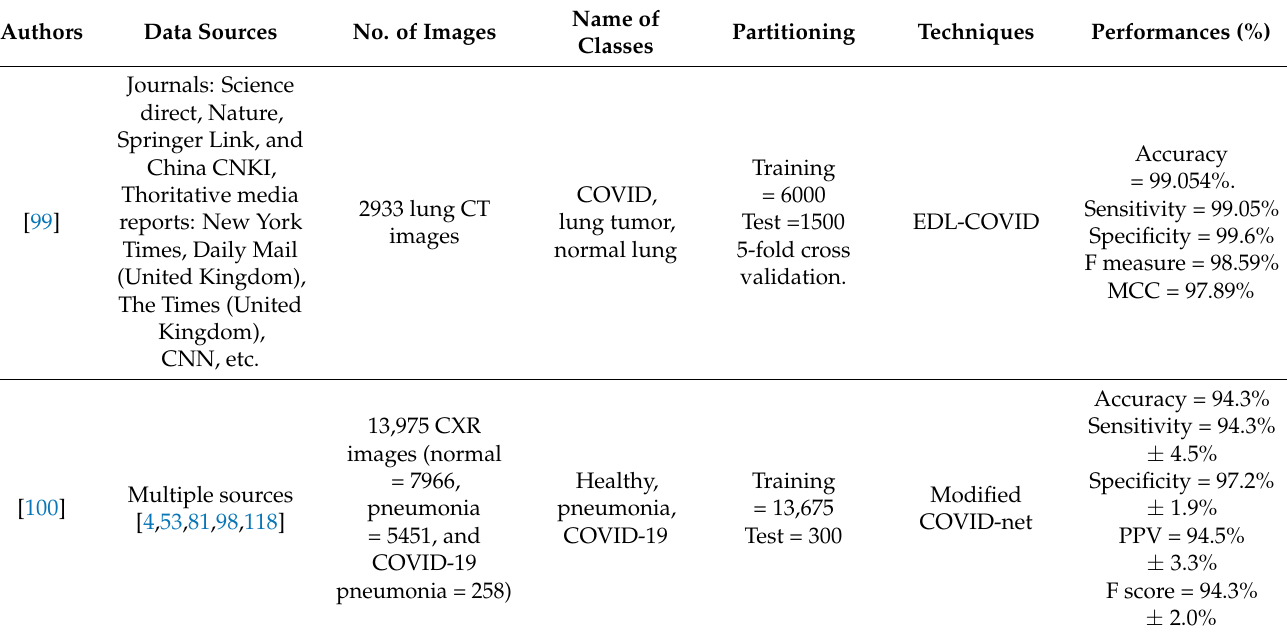
Table 8. Summary of deep learning based COVID-19 multi-classification using custom